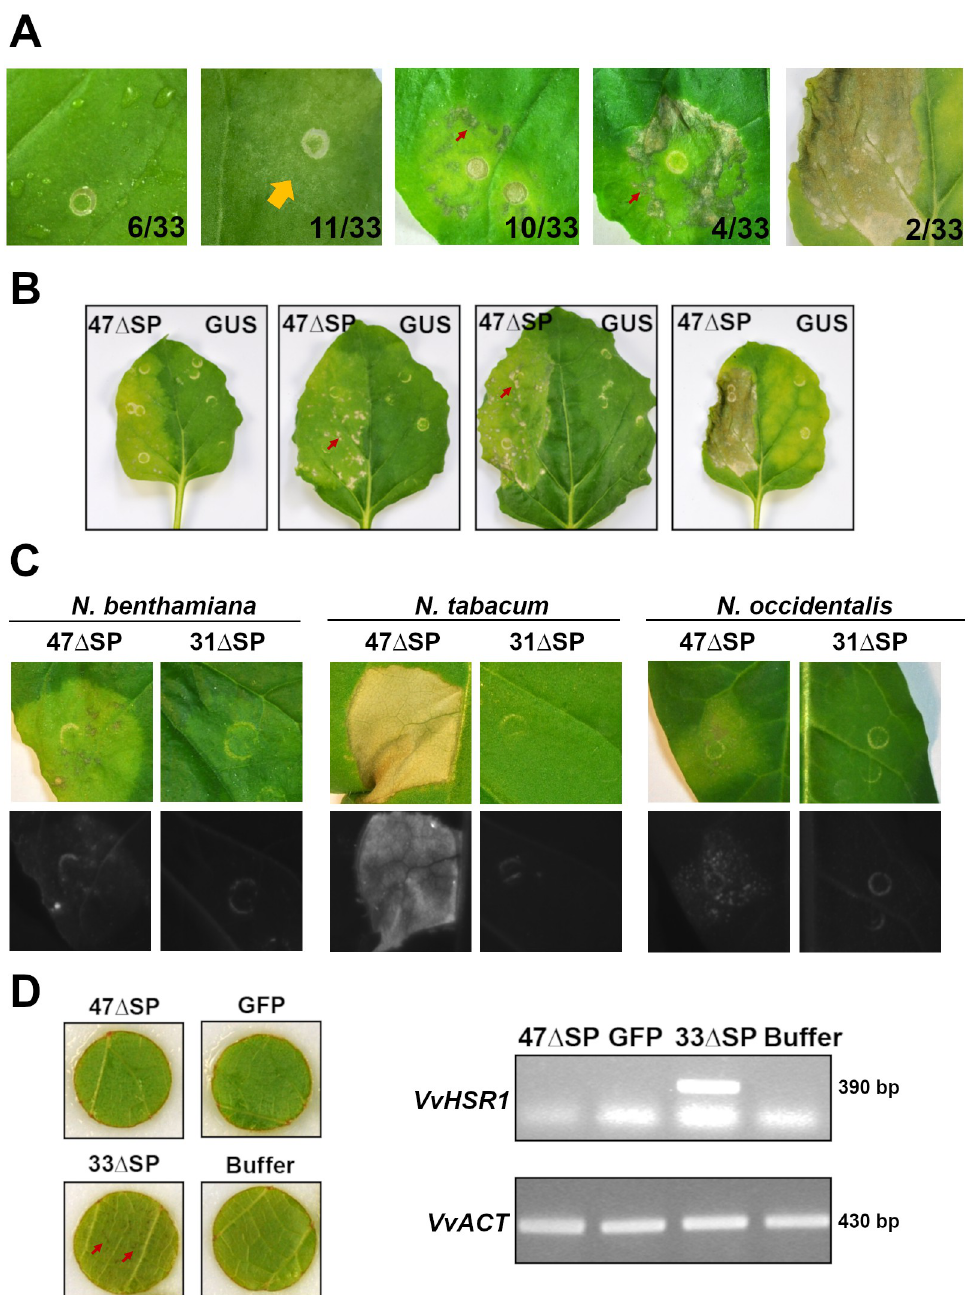
Fig 1. Candidate effector Pvit47 induces cell death in Nicotiana species. (A) Cell death induction following Agrobacterium -mediated transient expression of Pvit47 Δ SP (47 Δ SP) in N . benthamiana leaves. Cell death responses were assigned to one of five classes based on strength, from no response to uniform tissue collapse. Images are representative of the five classes and numbers indicate the number of responses falling inside each class. Results correspond to five independent experiments. Details of class definition and results for independent experiments are presented in S1 Table. Orange arrow indicates weak cell death and red arrows indicate patches of collapsing tissue. (B) Cell death induction following Agrobacterium -mediated transient expression of 47 Δ SP in plants belonging to the same batch. Agrobacterium - mediated transient expression of ß-glucuronidase (GUS) was used as negative control. Arrows indicate patches of collapsing tissue. (C) Cell death induction following Agrobacterium -mediated transient expression of 47 Δ SP in Nicotiana species. Top: daylight, bottom: blue light. Agrobacterium -mediated transient expression of candidate effector protein 31 Δ SP, reported not to induce cell death in Nicotiana spp . [16], is shown for comparison. (D) Cell death induction